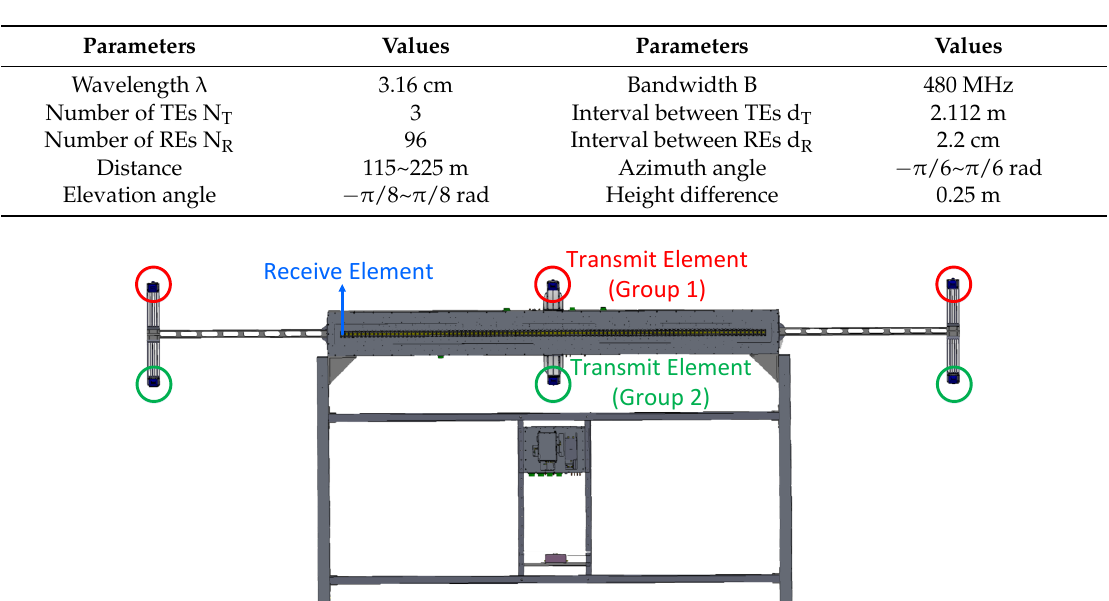
Figure 16. Angular PSF of modified MIMO array. Table 2. Parameters of the Experimental MIMO Radar System.